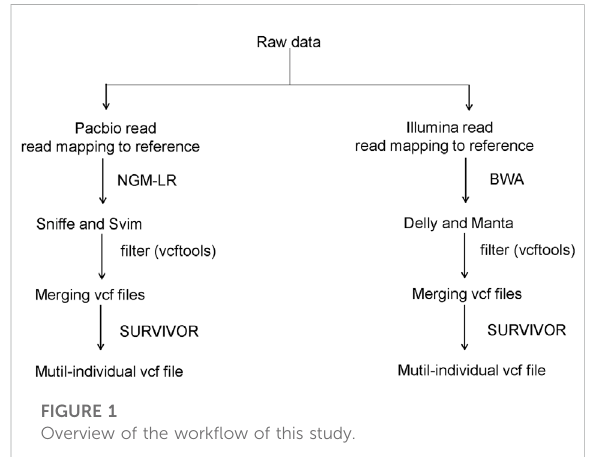
FIGURE 1 Overview of the work fl ow of this